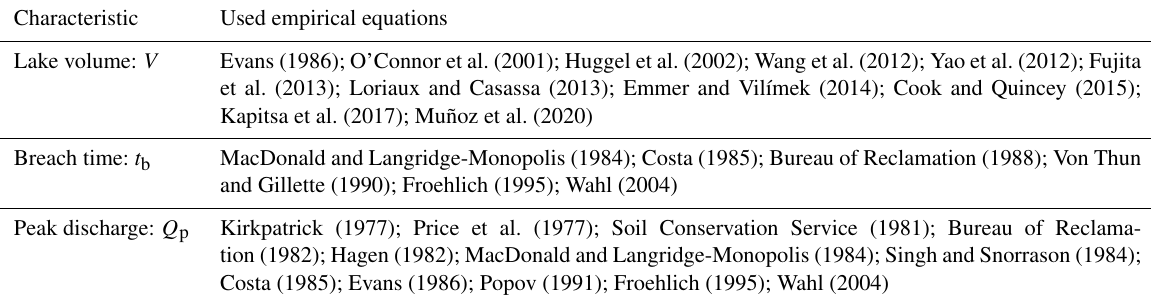
Table 2. A list of empirical equations used to estimate V , t b , and Q p (for detailed description of these equations see Supplement Table S1). Characteristic Used empirical